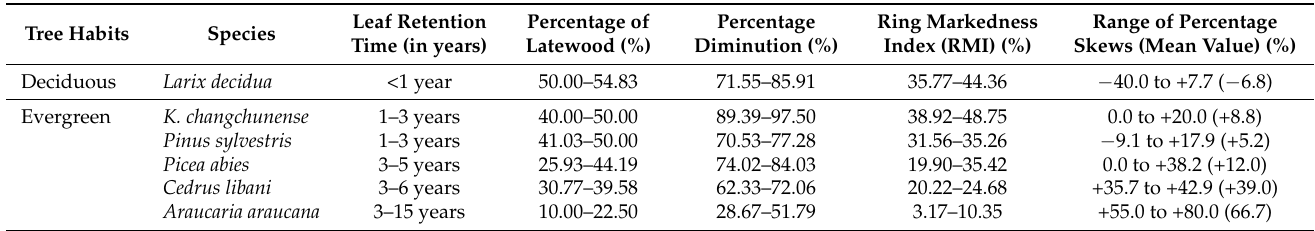
Table 3. Comparison of the quantification of ring markedness parameters for Keteleerioxylon changchunense sp. nov. with the five extant taxa (data from